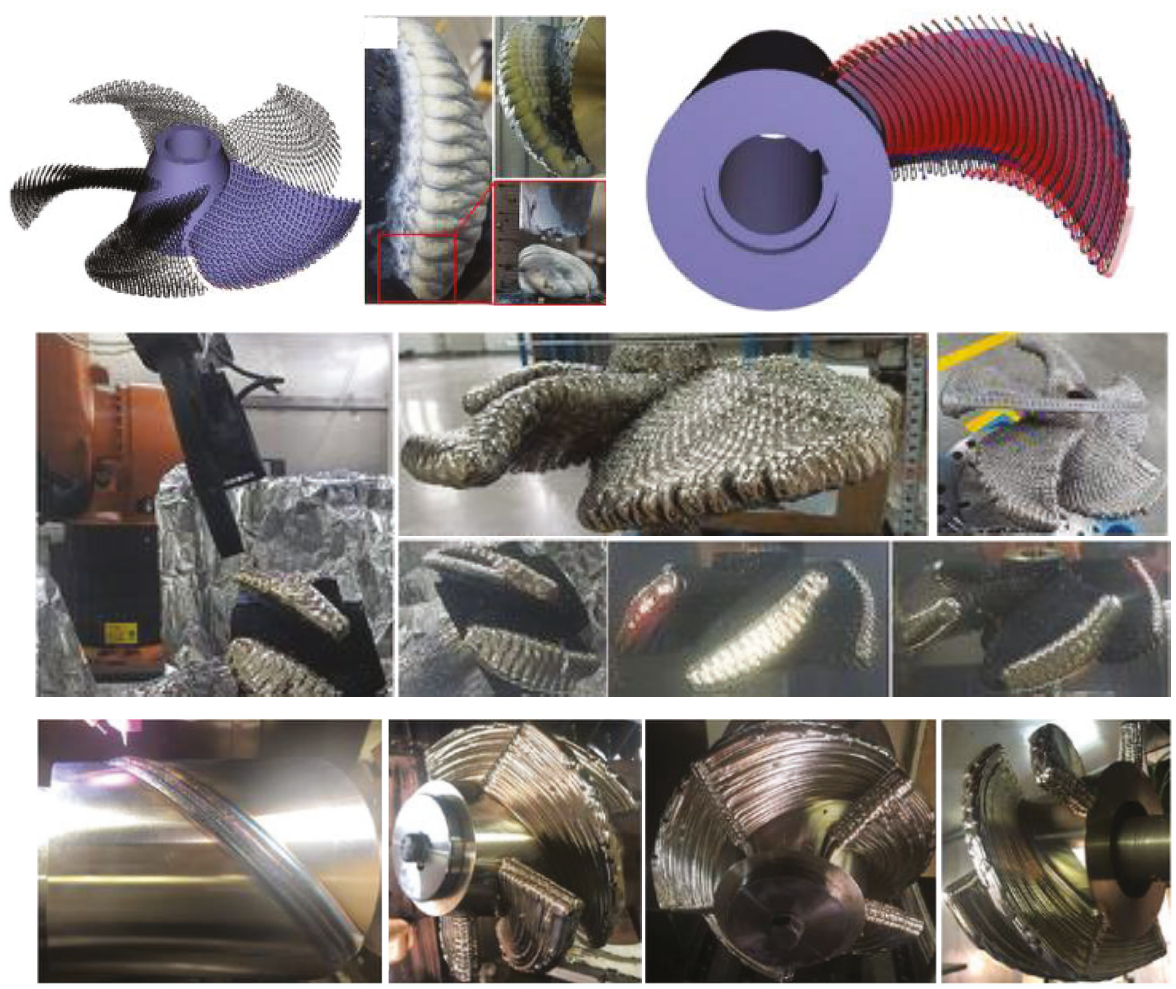
Figure 29: Path planning strategy and actual deposition